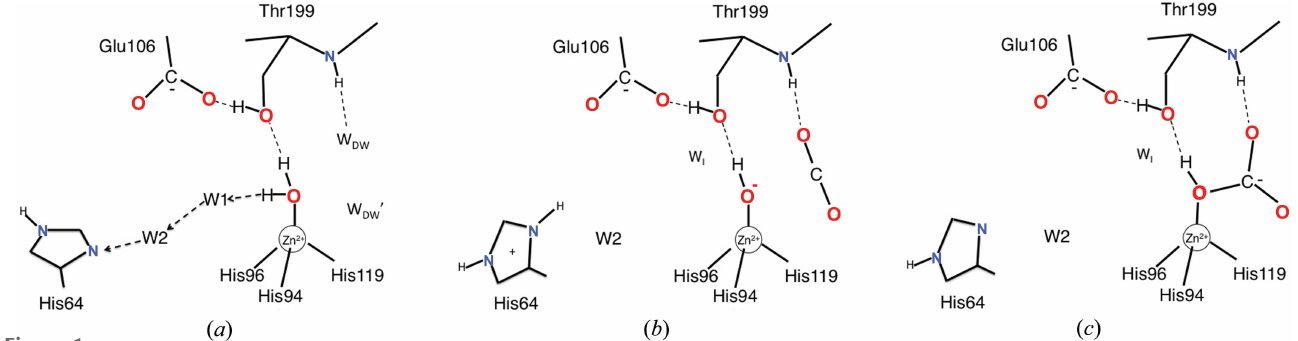
Figure 1 A likely catalytic mechanism for human carbonic anhydrase II. In the first step ( a ) the zinc water (W Zn ) releases a proton to His64 via W1 and W2. When carbon dioxide binds ( b ) it releases the two deep-water molecules. W1 disappears and is replaced by W I . His64 adopts the outward orientation to release the abstracted proton to bulk solvent. Then the W Zn makes a nucleophilic attack on the carbon of the carbon dioxide to form bicarbonate ( c ). Three water molecules rapidly replace the bicarbonate and His64 returns to its inward orientation ( a ). Several additional water molecules are identified and participate in the dynamic water structure of the active